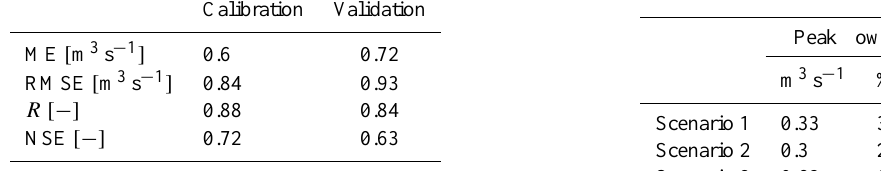
Table 7. Absolute and relative changes in peak and low flows at the outlet station of the Grote Nete catchment for empirical return peri- ods higher than 1 year and the different rainfall scenarios compared with the reference